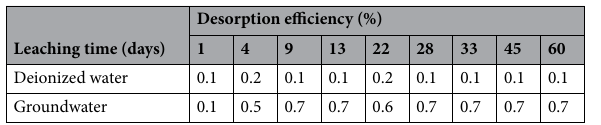
Table 2. Time-dependent desorption of 89 Sr from Z4A solid residue after reaction with SW.